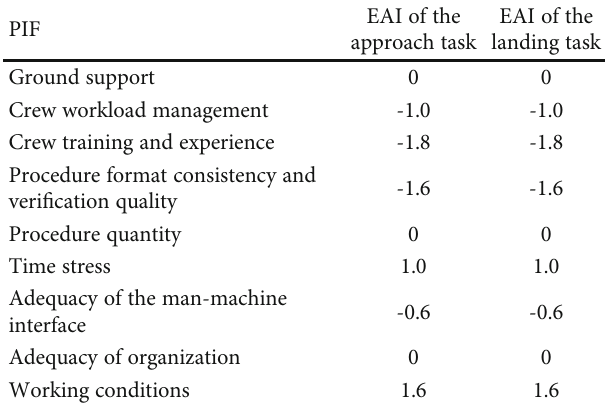
Table 8: EAIs for